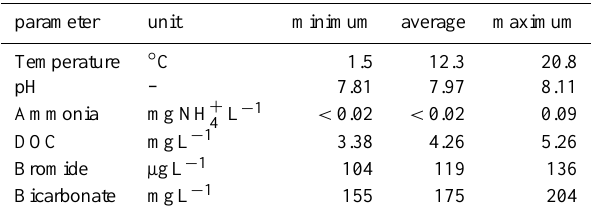
Table 1. Minimum, maximum and average values of relevant pa- rameters from RSF.